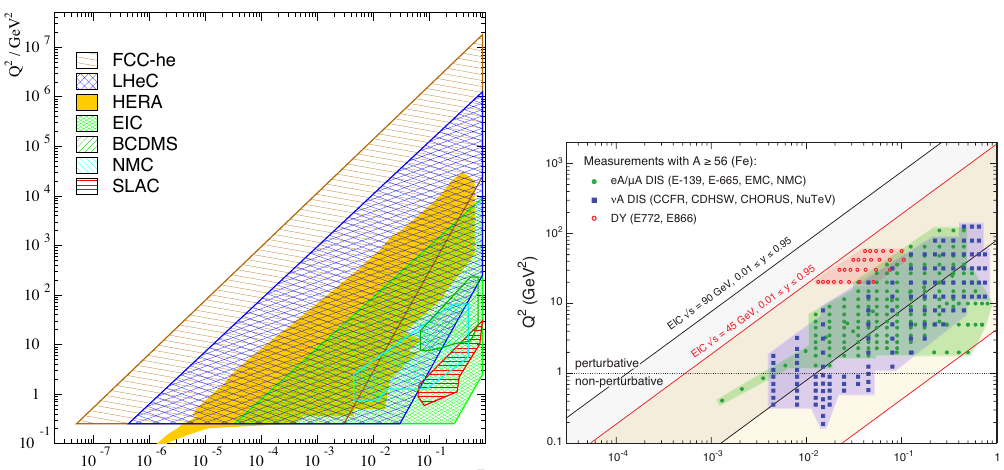
Figure 1: (Left) The kinematical coverage of various legacy and upcoming / proposed DIS experiments in x and Q 2 , from Ref. [ 5 ] . The wide kinematical coverage of both the EIC and LHeC intersect the regions probed by older fixed-target DIS experiments while extending into novel regions of low x and large Q 2 . (Right) A complementary map of the kinematical coverage of the EIC in DIS measurements involving heavier nuclei ( A ≥ 56); superposed are the placements of legacy data sets involving charged- lepton, ν A, and Drell-Yan (DY) information; taken from Ref. [ 4 ]